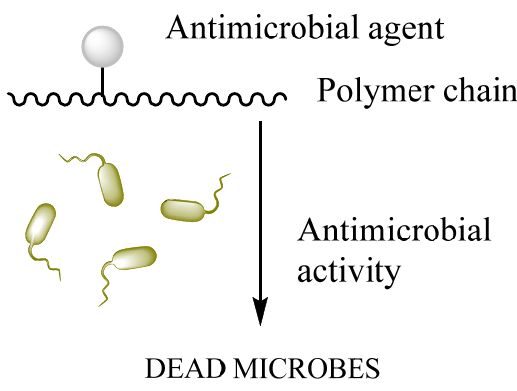
Figure 6. Surface functionalization of